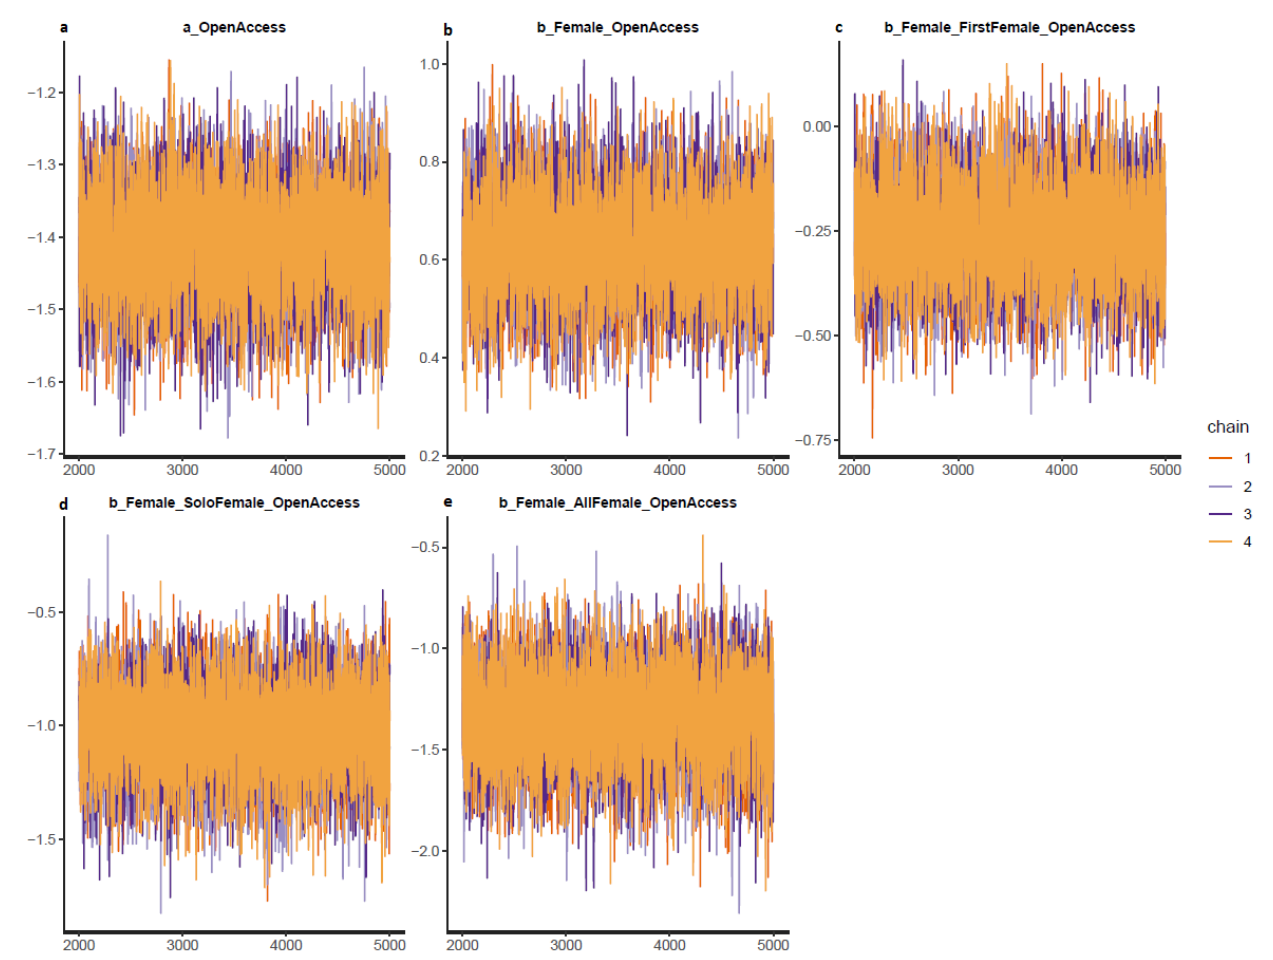
Figure 6. Trace plots of parameters: ( a ) Constant ; ( b ) Female ; ( c ) Female × FirstFemale ; ( d ) Female × SoloFemale ; ( e ) Female × AllFemale . Table 2. Simulated